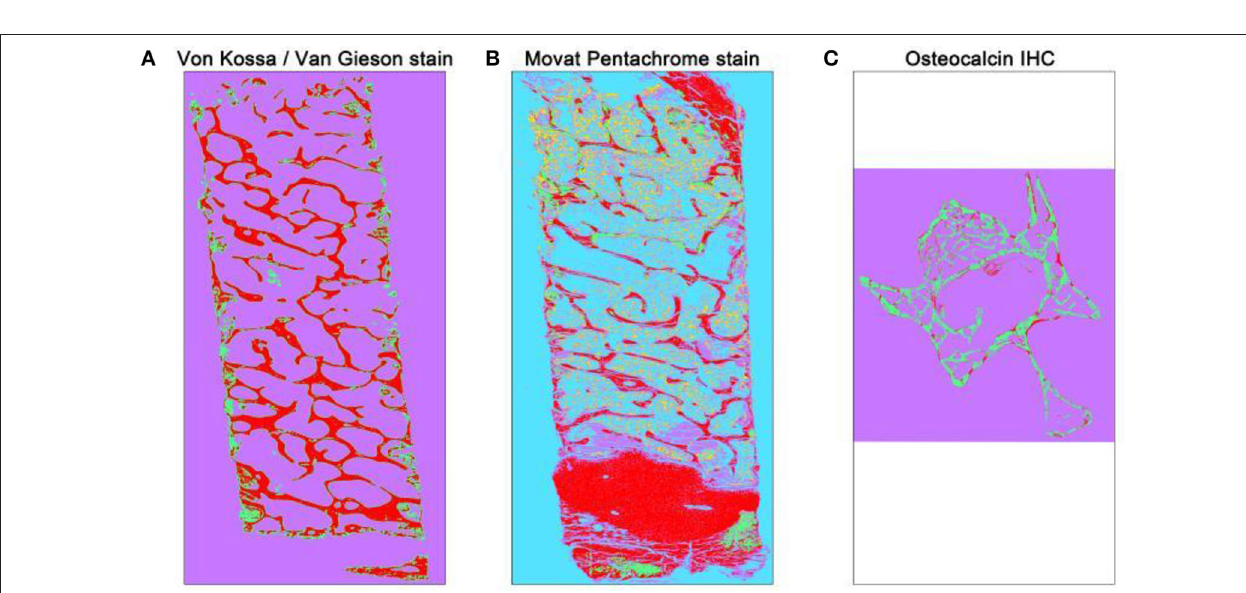
FIGURE 2 | Overview of automated segmented images using TWS. The automated classification was carried out after training one stack of the whole overview image. Different histological stains were trained according to different classes (A) Von Kossa/Van Gieson stain classified image depicts mineralized bone matrix as red and non-mineralized bone matrix as green. The magenta color here represents the background class. (B) Movat pentachrome stain classified image depicts ossified tissue as red, osteoid (non-mineralized) as green, cartilage as magenta, bone marrow as yellow, and background class as turquoise. (C) Osteocalcin classified image depicts osteocalcin positive as red, bone as green, and background as magenta.